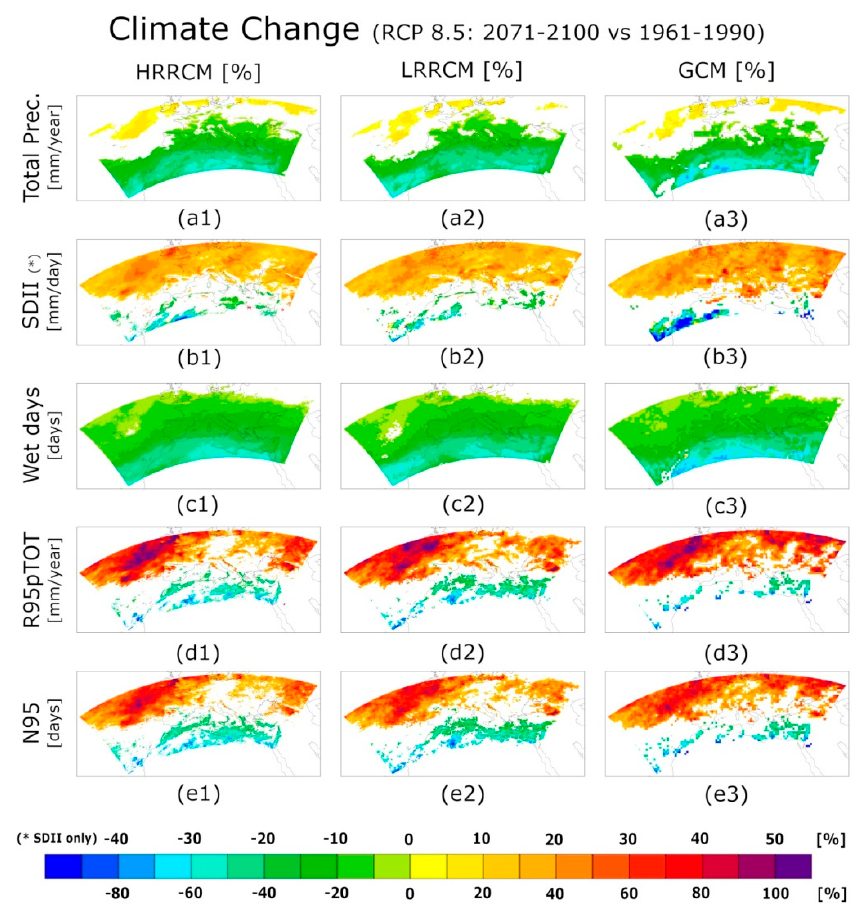
Figure 4. Change (percent, %) of the indexes defined in Section 2.2 in the RCP8.5 scenario simulation. All panels show the di ff erence between the 1961–1990 and 2071–2100 periods according the HRRCM (first column), the LRRCM (second column), the GCM (third column). White areas denote points where di ff erences are not statistically significant. Positive values denote higher index values in the future (2071–2100) period. Along the color bar, upper labels refer to SDII, the bottom ones refer to all the other indexes ( a1 – a3 ), annual total precipitation; ( b1 – b3 ), SDII index; ( c1 – c3 ), annual number of wet days; ( d1 – d3 ), annual total precipitation amount when daily precipitation is greater than 95th percentile; ( e1 – e3 ), number of days when RR ≥ RRwn95; Table 4. Fraction (percent, %) of points with positive, negative and no statistically significant climate change signal for the high-resolution regional simulation (HRRCM), the low-resolution simulation (LRRCM) and the global simulation (GCM). Each line refers to a different indicator (see Section 2.2). Values refer to the 2021–2050 period with respect to the reference period 1961–1990. The column positive/negative denote points where the difference between the near-term (2021–2050) and the reference (1961–1990) time periods in the RCP4.5and RCP8.5 are statistically significant. Positive values denote high indicators in the future (2021–2050) period.